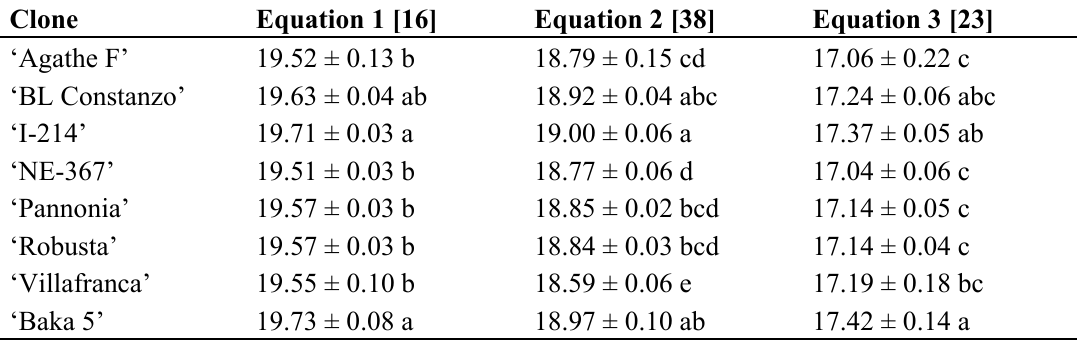
Table 7. Higher heating values (kJ g − 1 ) for the examined clones of Populus as calculated from Equations 1–3. Data represent means ±